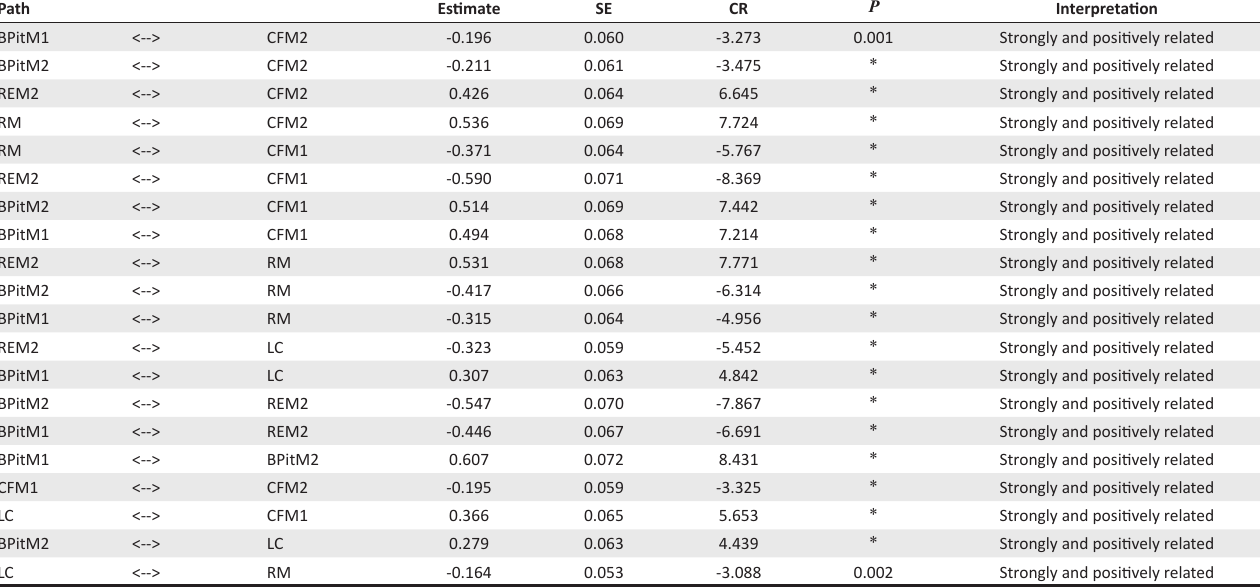
TABLE 9: Covariance for paired independent